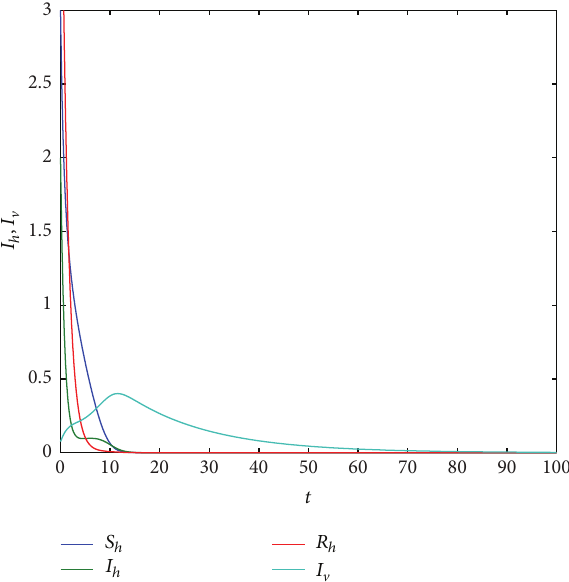
Figure 9: Trajectory picture with time 𝑡 when 𝑟 = 0.8 , 𝐾 = 10 , = 1 , 𝑎 = 1 , 𝑎 = 0.3 , 𝑑 𝛽 1 1 2 = 0.06 , 𝛽 = 0.26 , and 𝑁 𝑑 V 2